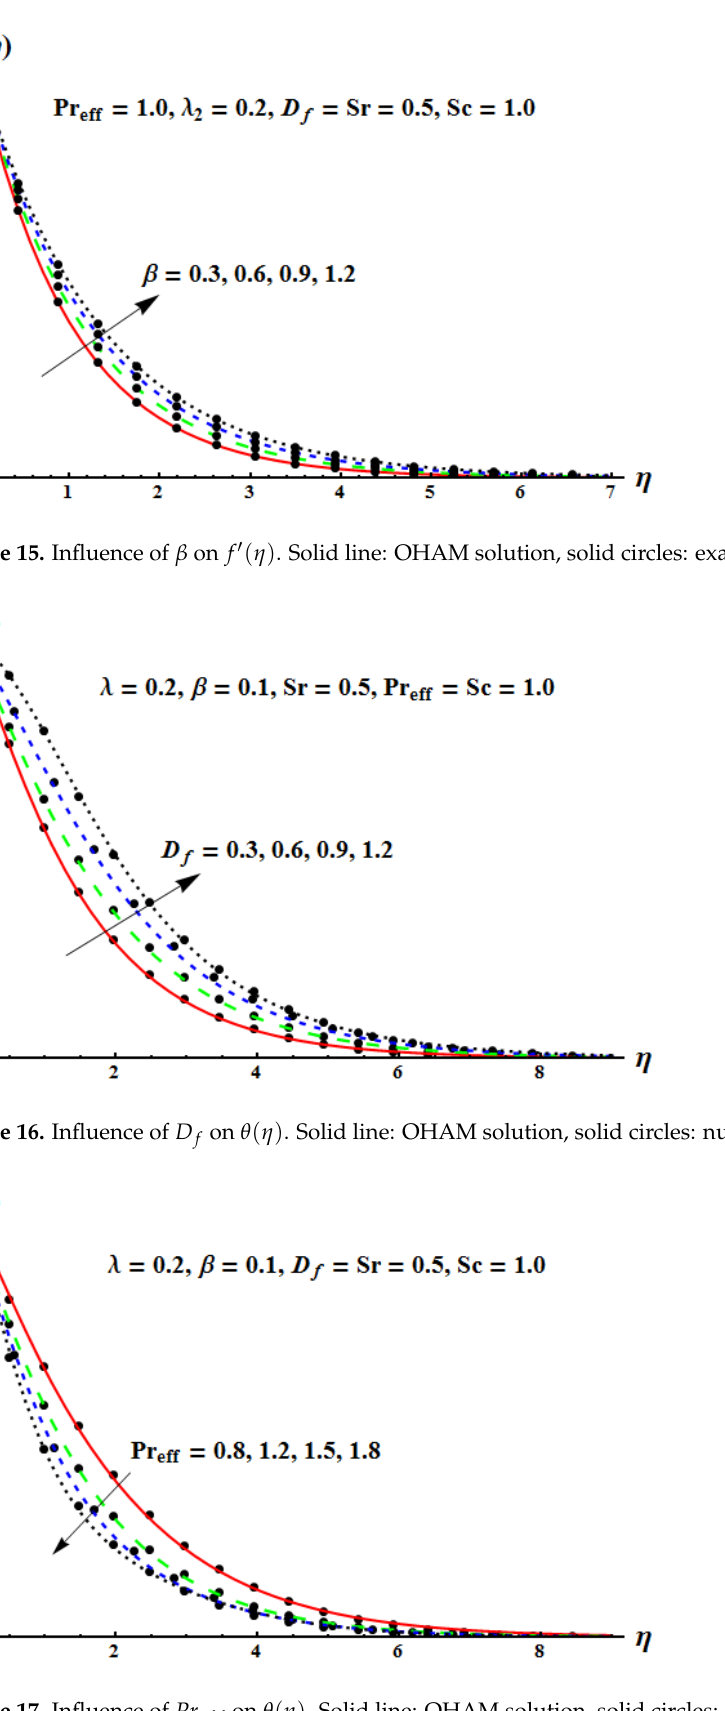
Figure 17. Influence of Pr ef f on θ ( η ) . Solid line: OHAM solution, solid circles: numerical